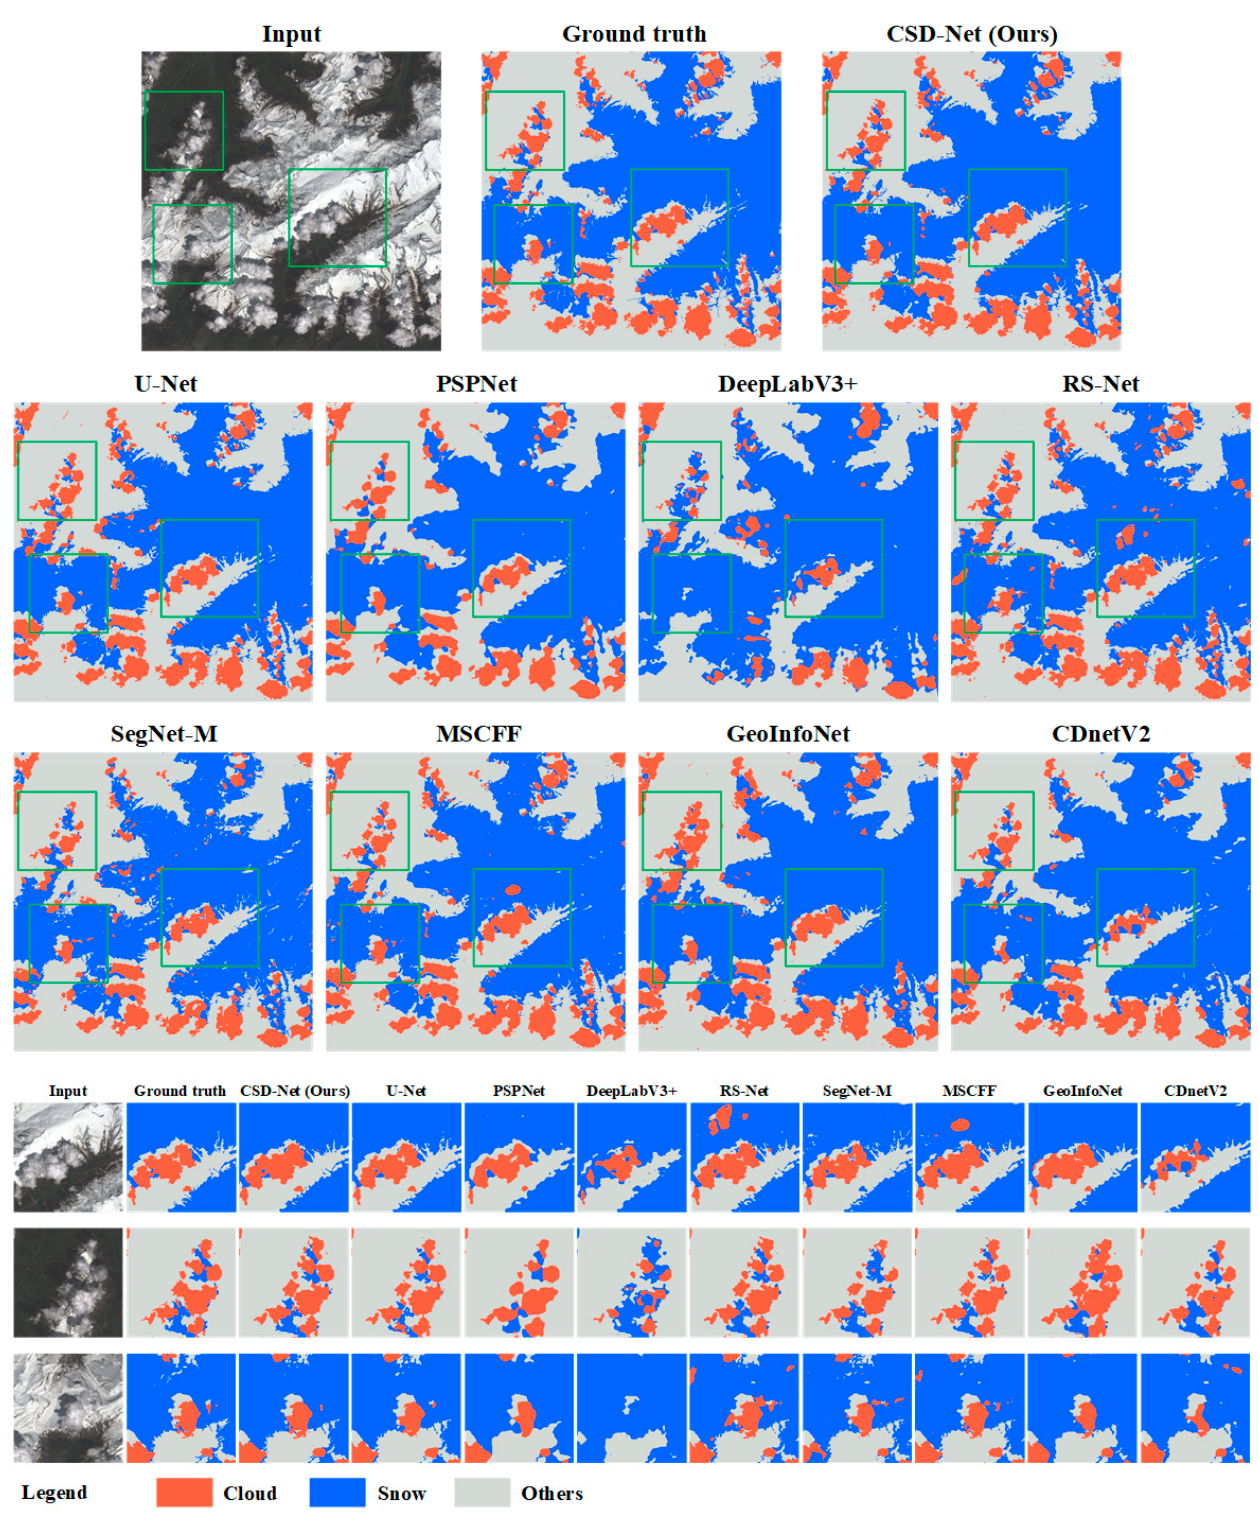
Figure 8. Large scene visualization of cloud and snow detection results by different methods based on the L8_SPARCS dataset. The delineated areas with the green boxes were magnified to provide a more detailed visual comparison in the bottom columns.